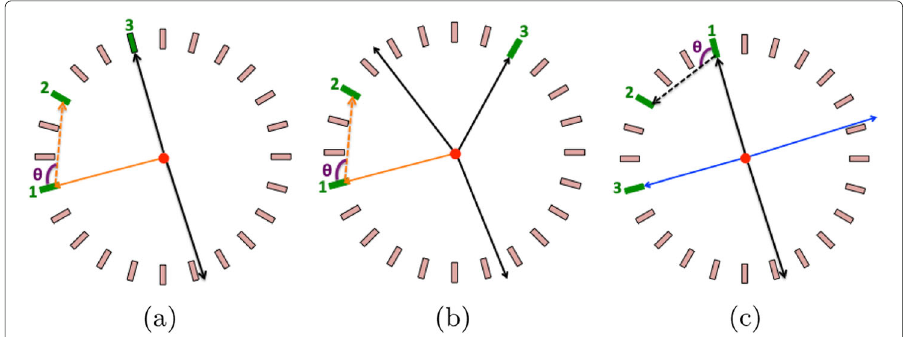
Fig. 8 Three different cases in the events selection for the 1275 keV photons (orange arrows) based on the delayed decay of ortho-positronium atoms: a The first case shows the two annihilation photons (black arrows) from the decay of para-positronium (or ortho-positronium pick-off). b The photons originating from the decay of ortho-positronium state (three black arrows). c A possible source of background in the adopted procedure for the selection of prompt photon due to the accidental coincidences. The black and blue solid lines presenting the back-to-back annihilation photons might originate from two different